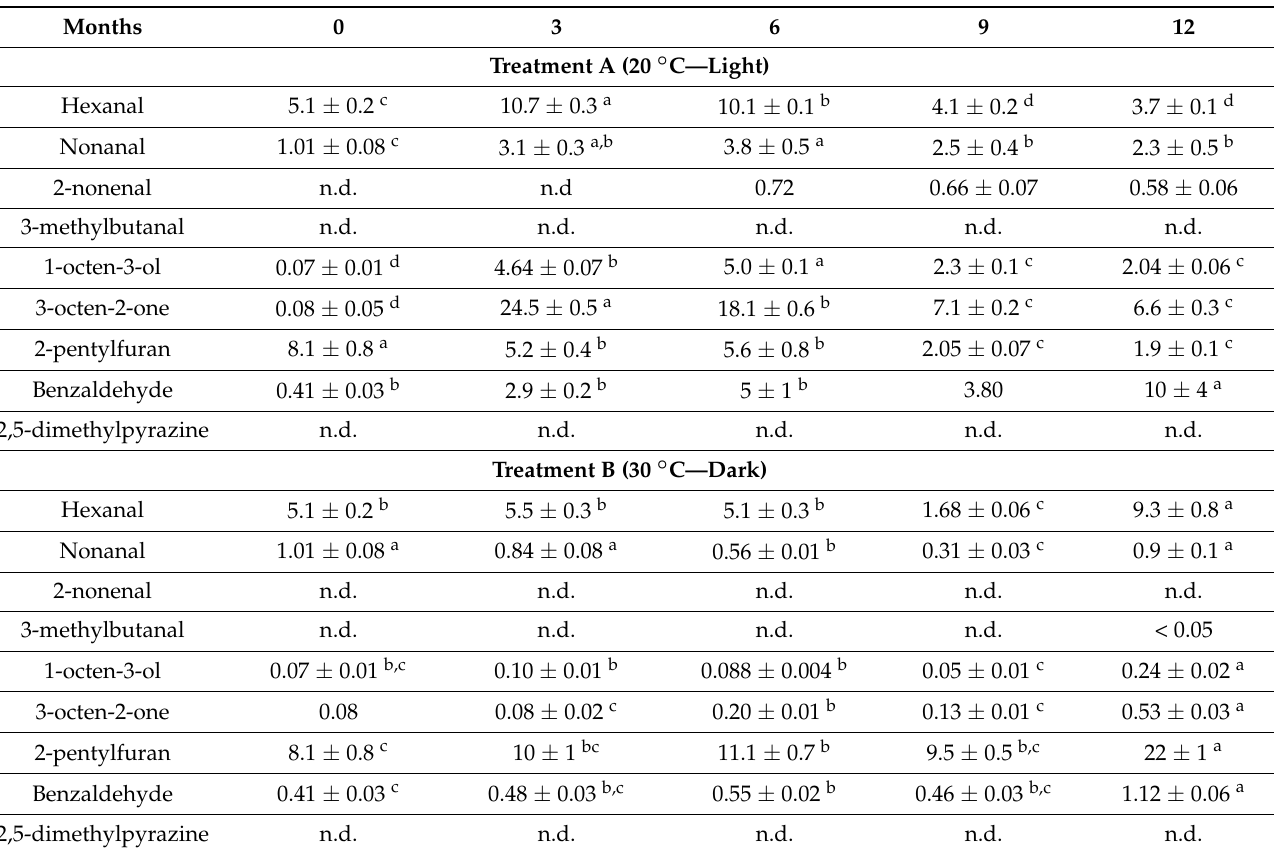
Table 3. Evolution of the nine compounds of interest during the ageing, in µ g of compound/g of sample ( n = 3).